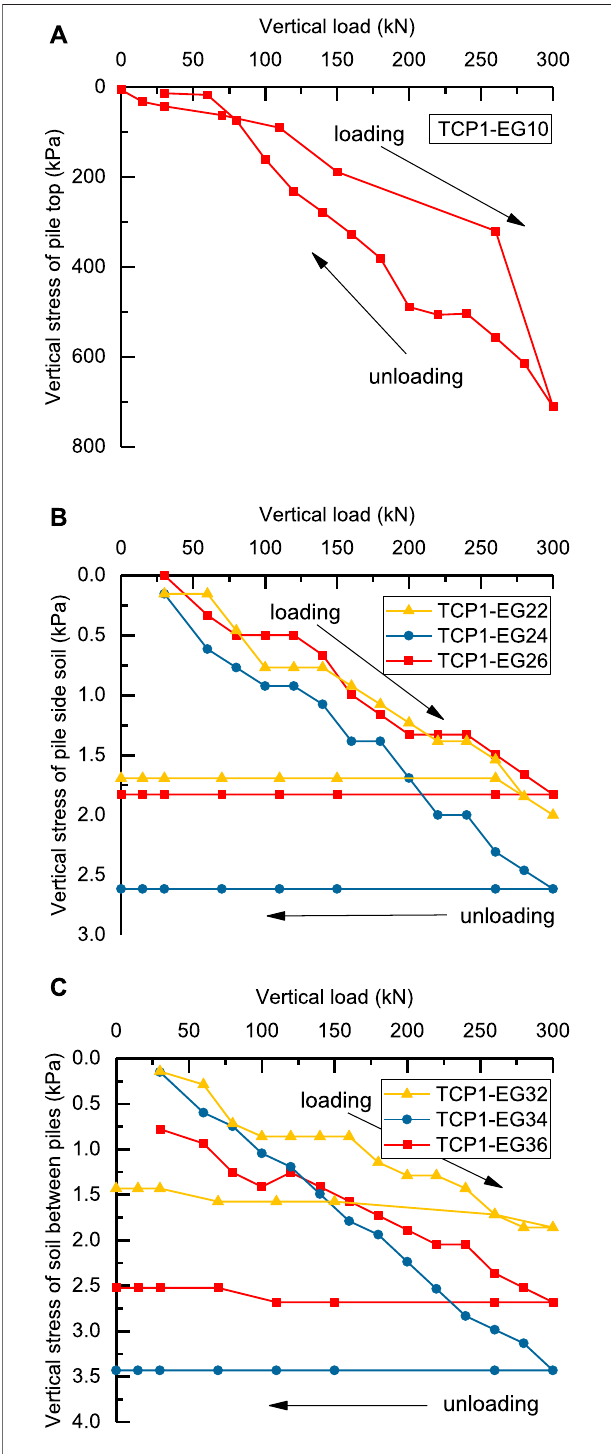
FIGURE 7 | Variation curves of vertical stress in loading-unloading process of TCP1 at (A) pile top; (B) pile side soil; (C) soil between